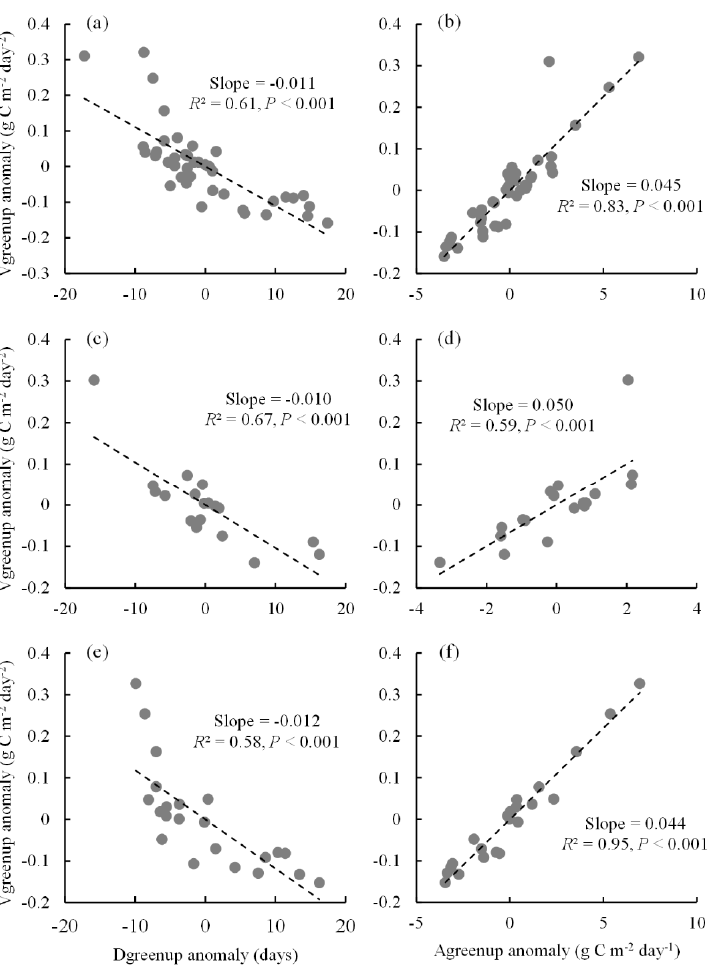
Figure 3. The spatial relationships between Vgreenup anomalies and Dgreenup anomalies as well as Agreenup anomalies. ( a − b ) The spatial relationships across all sites in both Europe and North America; ( c − d ) the spatial relationships across all sites in Europe; ( e − f ) the spatial relationships America; ( c , d ) the spatial relationships across all sites in Europe; ( e , f ) the spatial relationships across across all sites in North America. all sites in North